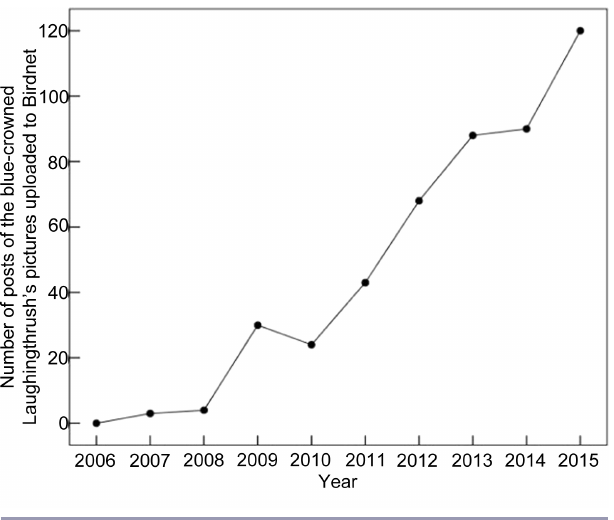
Fig. 1 . Numbers of posts of the Blue-crowned Laughingthrush’s ( Garrulax courtoisi ) pictures uploaded to Birdnet since